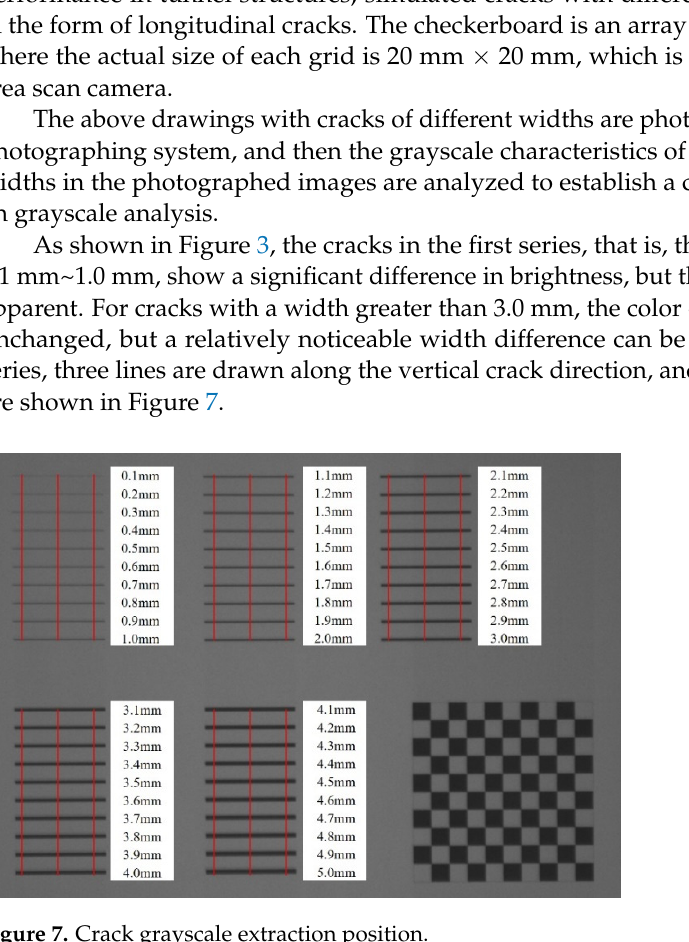
Figure 7. Crack grayscale extraction position.